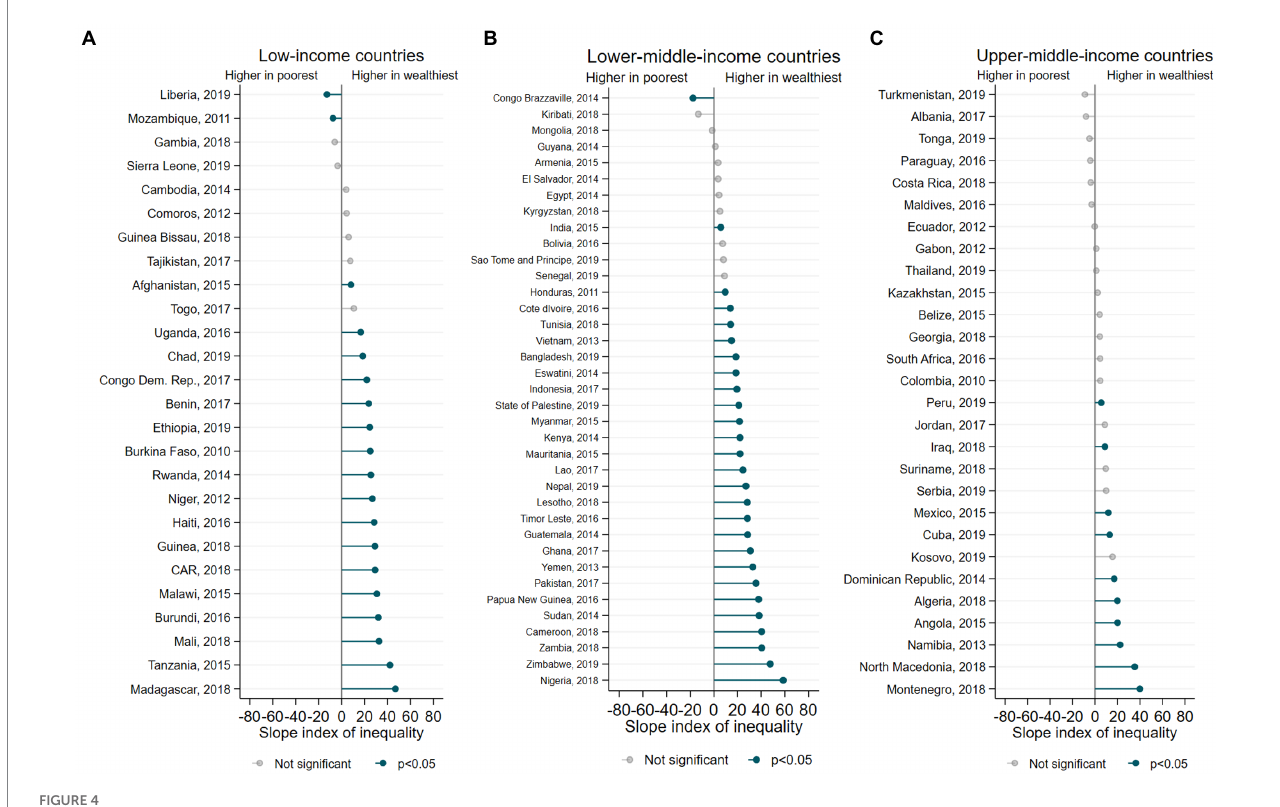
FIGURE 4 (A-C) Inequalities in the EFF prevalence according to wealth